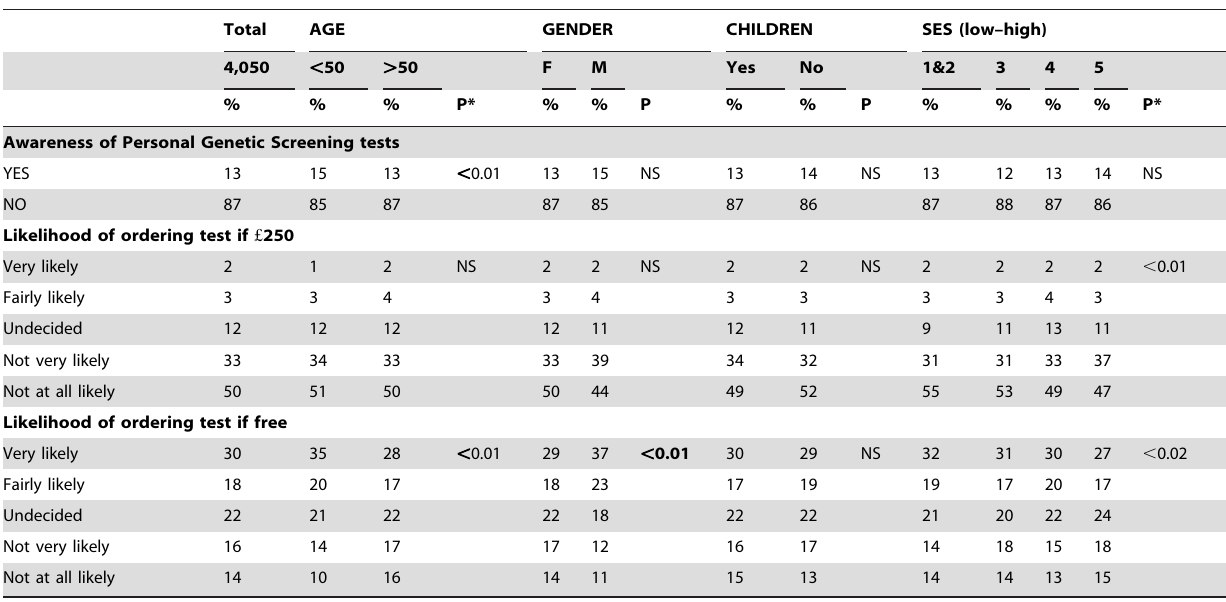
Table 2. Interest in Personal Genetic